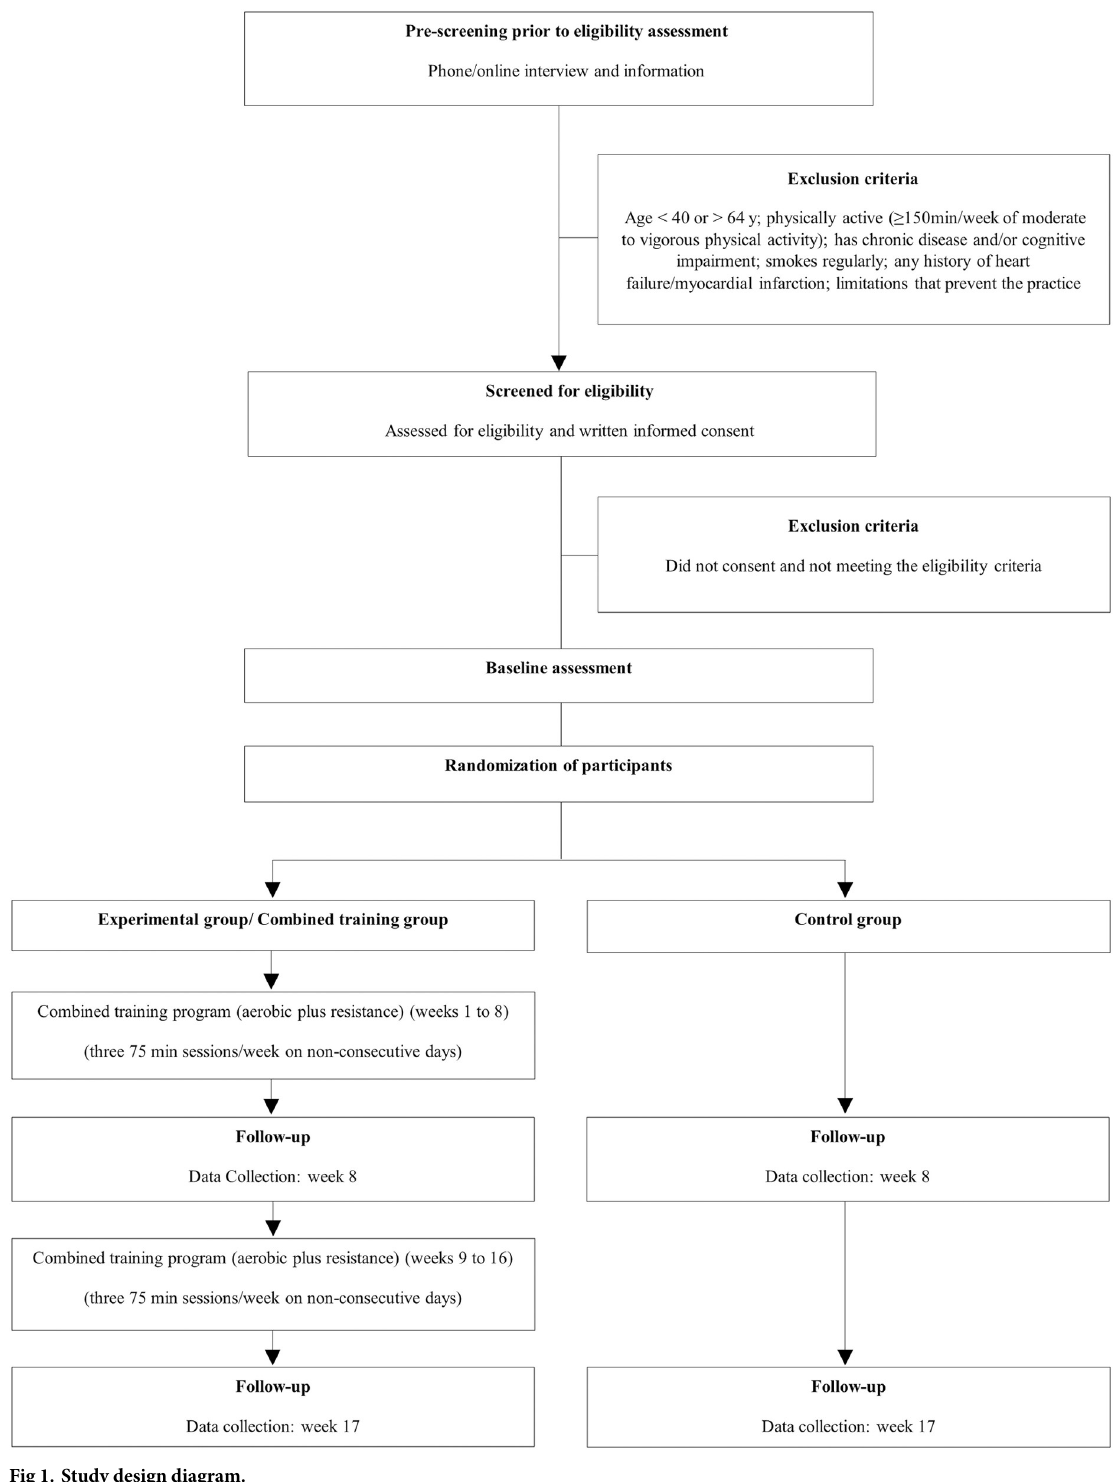
Fig 1. Study design